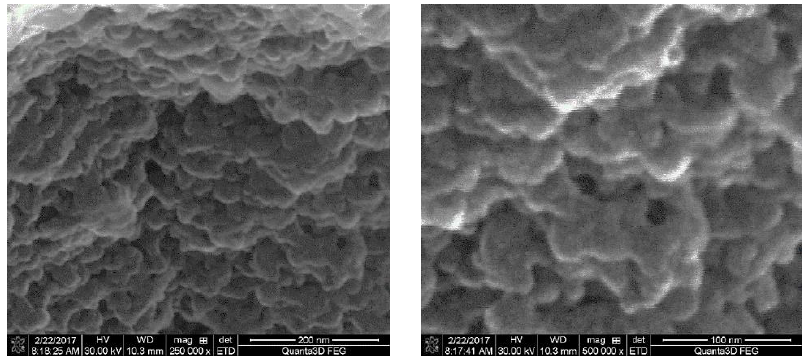
Figure 3. SEM micrographs of the surface of GE microsphere.